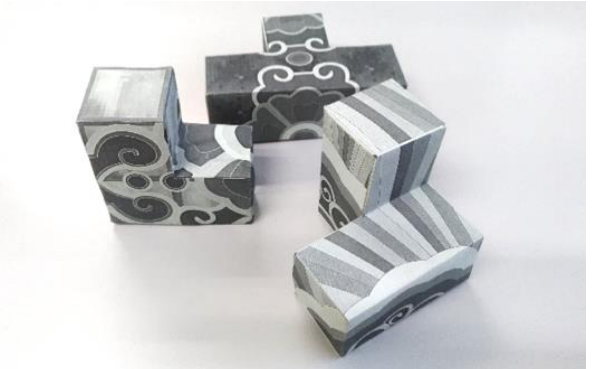
Figure 10. Practice session to form a cube from four simple elements.